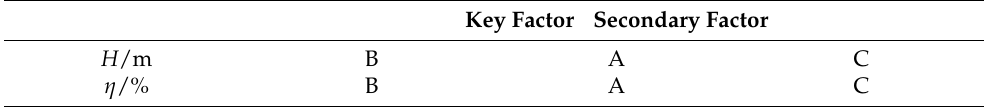
Table 9. The order of influence of the factors on pump performance at 1.0 Q des